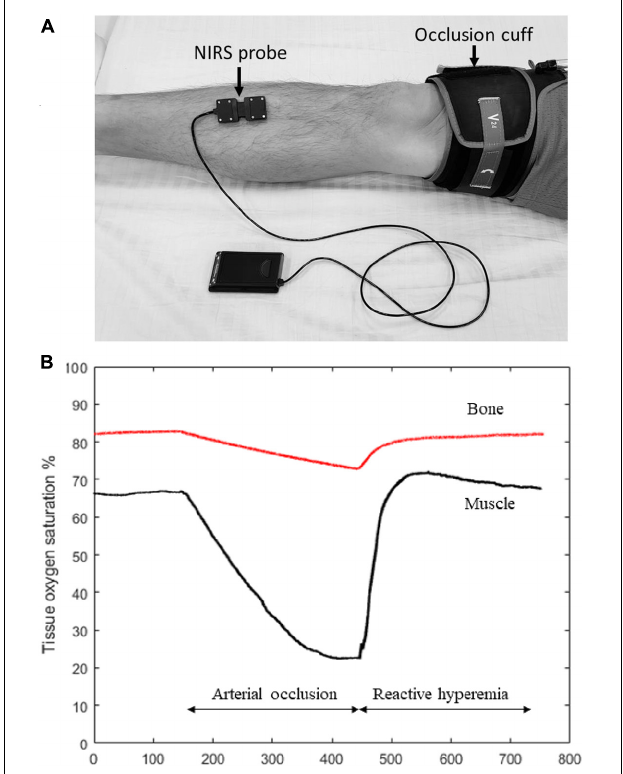
FIGURE 1 | (A) Experiment set-up for measuring tibia reactive hyperemia. A NIRS probe is placed at the medial aspect of the tibia and attached to the skin with double-sided tape. Pre-wraps are also usually used to wrap around the NIRS probe to ensure that the probe is secure in place but also not too tight. An occlusion cuff connected to a rapid cuff inflation system is placed above the knee to provide arterial occlusion. (B) Figure showing muscle (black line) and bone (red line) NIRS oxygen saturation changes during the reactive hyperemia experiment. Compared to muscle, the magnitude of oxygen reduction in bone is expected to be smaller during arterial occlusion, and it takes longer time for bone to recovery oxygenation levels after the occlusion is released. The results in this figure are roughly based on results see in the few studies performed on tibial bone with the expected results from skeletal